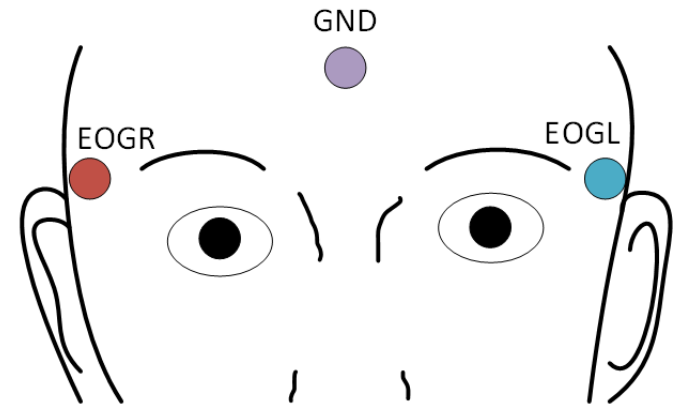
Figure 3. Schematic diagram of the EOG measurement.